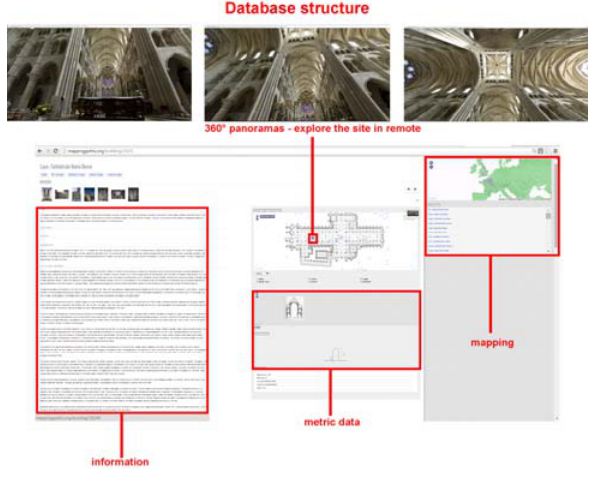
Figure 2. Mapping Gothic France is an interesting cultural Heritage application, it's a database based on the systematic use of 360° panoramic imagery.